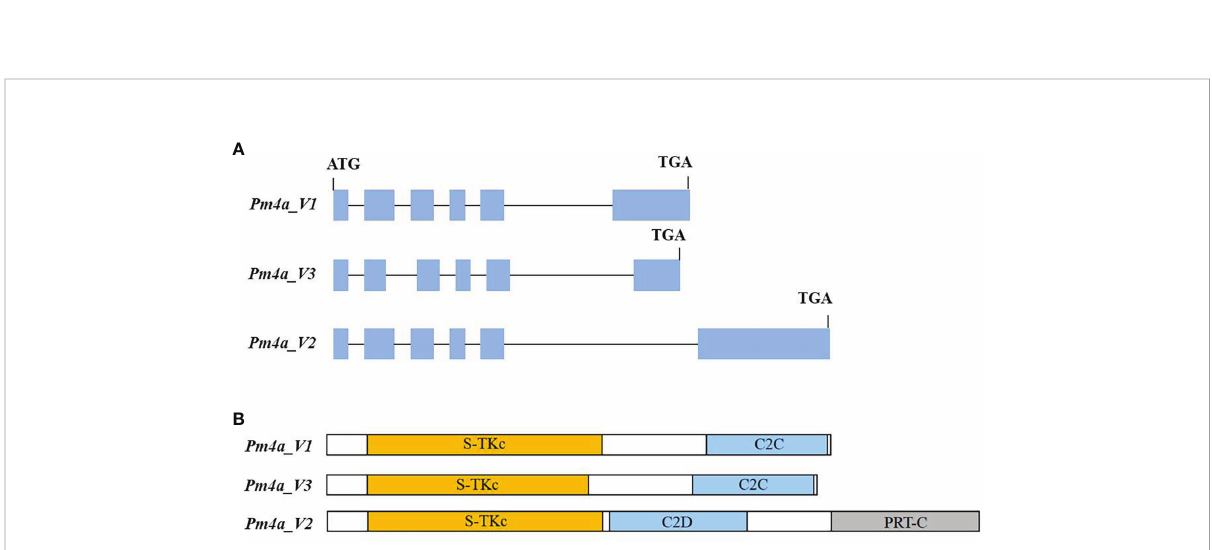
FIGURE 4 (A) Schematic representation of gene structures of PmYAV splicing variants. Gene exons and introns are shown by blue boxes and black lines, respectively. (B) Pm4a_V1 , Pm4a_V2 and Pm4a_V3 protein isoforms with domains indicated by colours: yellow, serine/threonine kinase (S-TKc); light blue, C2; grey, phosphoribosyl transferase C-terminal